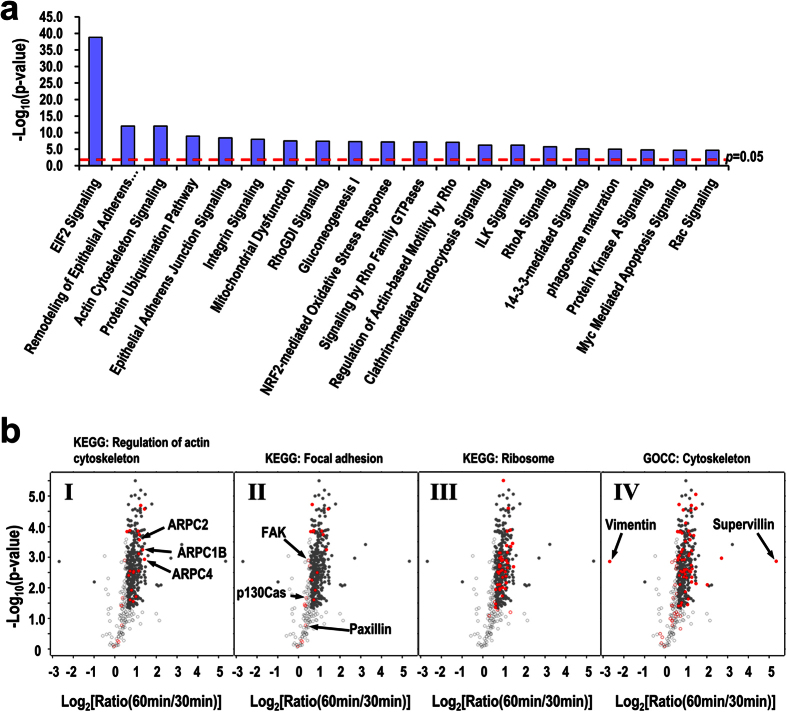
Bioinformatic analysis of the significantly changed pY proteins.(a) Representative pathways enriched in the significantly changed pY proteins as predicted by IPA analysis. The red dashed line indicates the threshold of the Fisher’s exact test of the significance (p < 0.05). (b) Scatter-plots showing the distribution of fold changes of pY proteins between the active and the early spreading stages. The red spots indicate the proteins involved in specific KEGG pathways or GO terms as indicated. X-axis: logarithm transformed fold change, Y-axis: logarithm transformed p-vlaue of Student t-test. The filled cycles represent proteins with a fold change >1.5 and a p < 0.05.